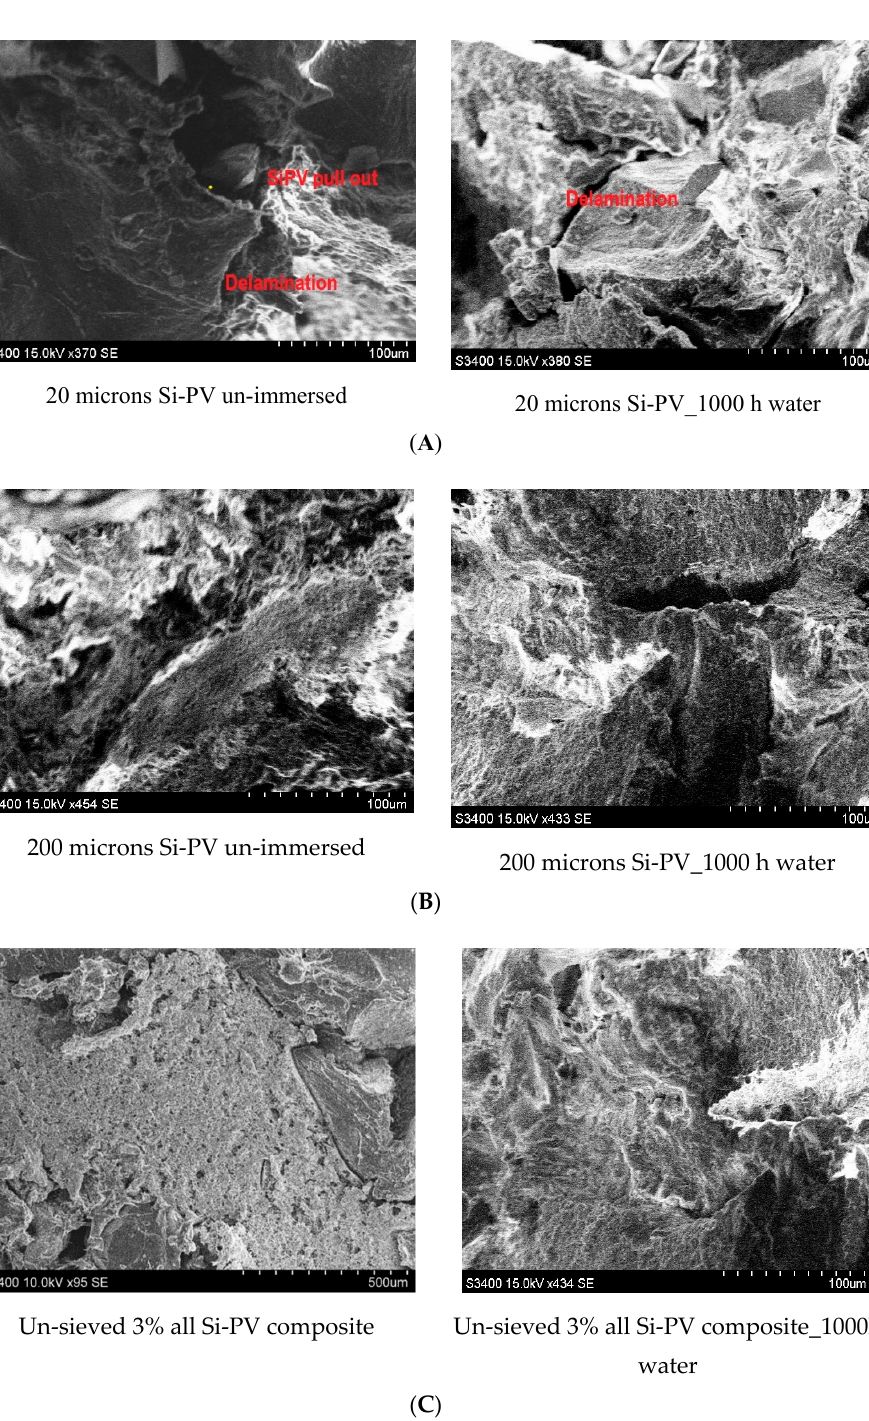
Figure8. SEMmicrographsof: ( A )20micronsSi-PVsample, ( B )200micronsSi-PVsample, ( C )un-sieved Figure 8. SEM micrographs of: ( A ) 20 microns Si-PV sample, ( B ) 200 microns Si-PV sample, ( C ) un- Si-PV sieved Si-PV samples.